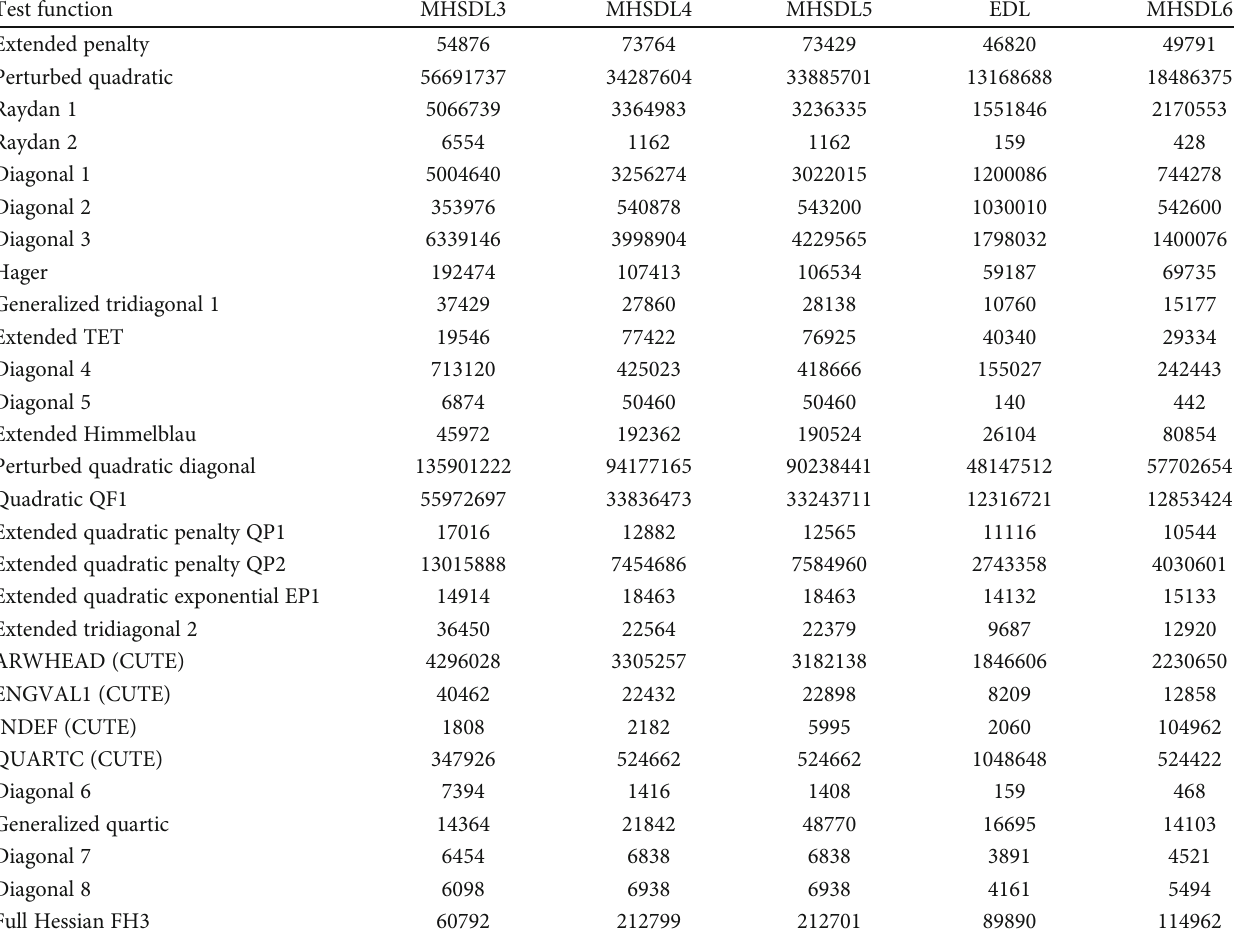
Table 2: Summary results of EDL, MHSDL3, MHSDL4, MHSDL5, and MHSDL6 methods with respect to